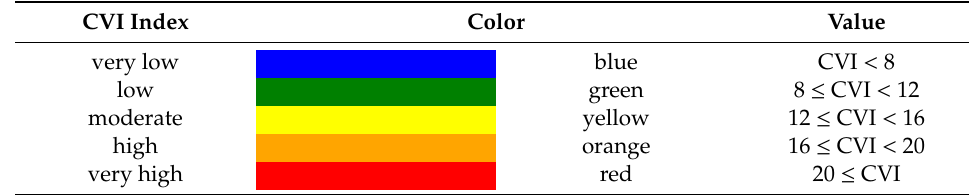
Table 2. Vulnerability categories.